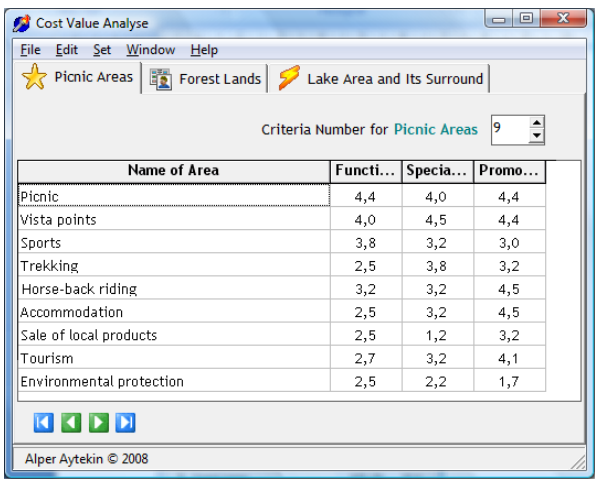
Figure 6. Data entrance section of the software.